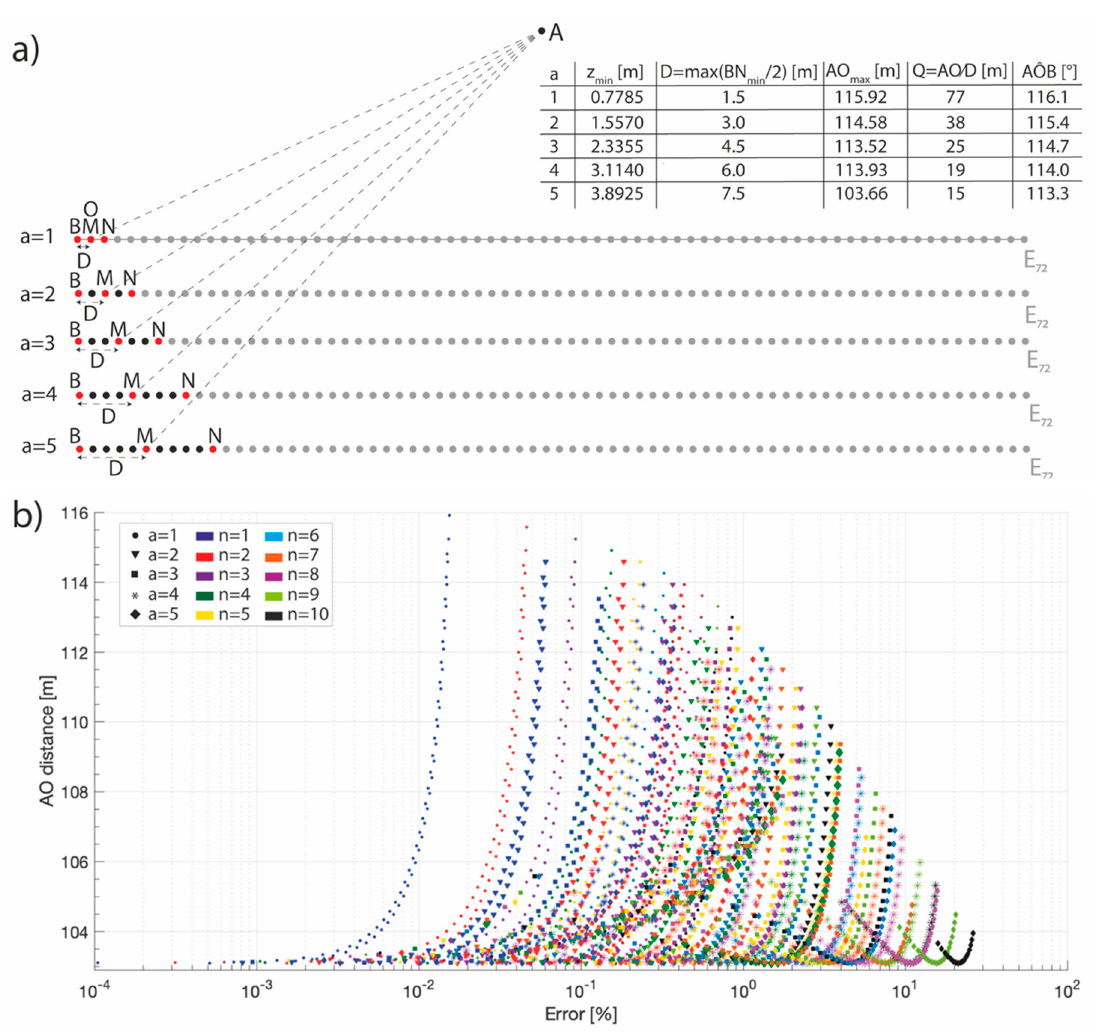
Figure 11. ( a ) Graphical description of the quantities involved in the computation of the infinite length coefficient (Q) and of the angle between the remote pole (A) and the first electrode of the tomography (B), calculated for each increment of the fixed inter electrode distance a according to the definitions provided by Razafindratsima and Lataste [29]. A and B are the current electrodes, M and N the voltage electrodes, O is the center of the maximum quadripole, and D the maximum quadripole half length. In the table, for each increment of a, are indicated the maximum investigation depth (after [39]), the D (the half of BN max length) and AO lengths, and the values of Q and AÔB. ( b ) Distribution of the error, induced by the finite remote pole position, with respect to the AO length for each increment of the inter electrode distance (different symbols) and of the n value (different colours).